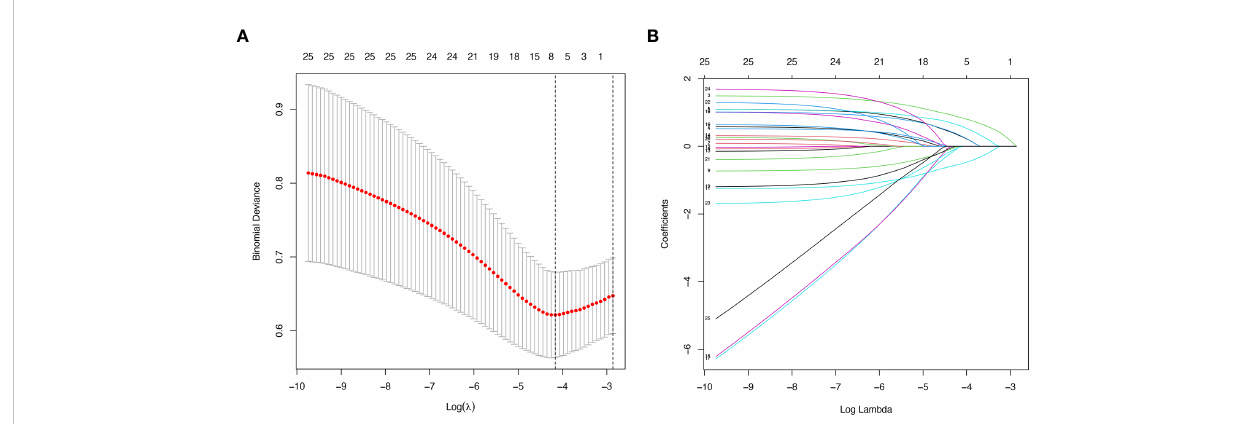
FIGURE 1 Demographic and clinical features selection using the LASSO regression model. (A) Optimal tuning parameter ( l ) selection in the LASSO regression model used ten-fold cross-validation via minimum criteria. The binomial deviance curve was plotted versus log ( l ). Dotted vertical lines were drawn at the optimal values by using the minimum criteria and 1 standard error (SE) of the minimum criteria (the 1-SE criteria). (B) LASSO coef fi cient pro fi les of the 35 features. A coef fi cient pro fi le plot was produced against the log ( l ) sequence. Vertical line was drawn at the value selected using ten-fold cross-validation, where optimal lambda resulted in 7 features with nonzero coef fi cients.